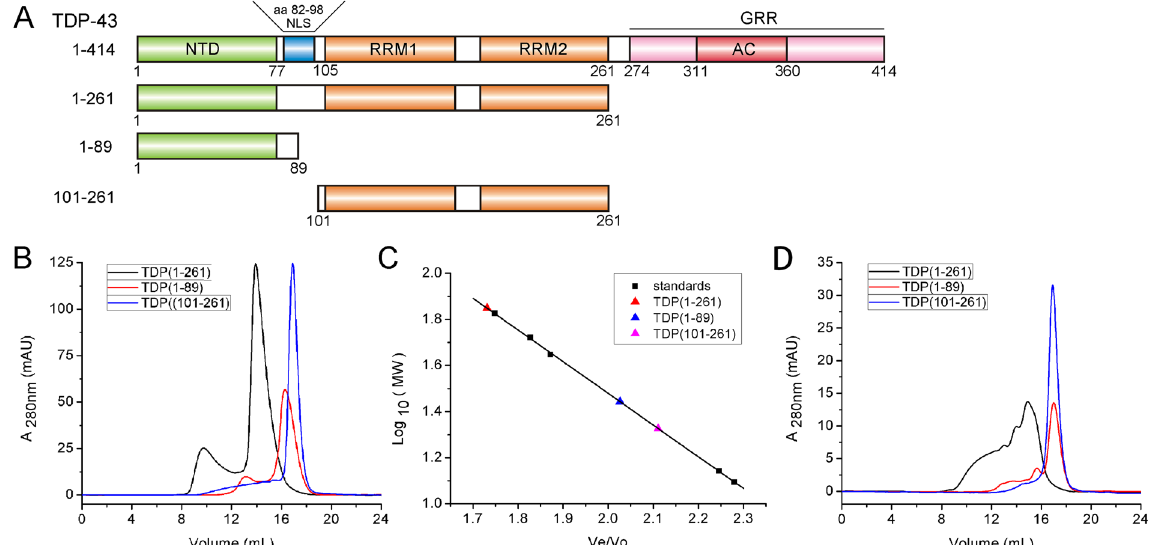
Figure 1. Characterization of the oligomeric states of the N-terminal fragments of TDP-43 by SEC. ( A ) Schematic representation of the domain architecture of TDP-43 and its N-terminal fragments. NTD, N-terminal domain; NLS, nuclear localization signal; RRM, RNA recognition motif; GRR, glycine-rich region; AC, amyloidogenic core. ( B ) SEC analysis of the N-terminal fragments of TDP-43. The proteins were diluted with Buffer A (25 mM Tris-HCl, pH 8.0, and 150 mM NaCl) to a concentration of 50 µ M and loaded onto a Superdex-200 Increase 10/30 GL column. The chromatographic profiles are shown for TDP(1–261) (black), TDP(1–89) (red), and TDP(101–261) (blue). A 280nm , Absorbance at 280 nm; mAU, micro absorbance unit. ( C ) Standard profile for calculating the apparent molecular weight (MW). V e /V 0 , relative elution volume. The standard markers are: BSA (67.0 kDa), GST (52.6 kDa), ovobumin (44.3 kDa), thioredoxin (13.9 kDa), and cytochrome C (12.4 kDa). The concentrations of the standards are around 10 to 100 μ M. ( D ) As in (B), SEC profiles of the N-terminal fragments of TDP-43 at 10- µ M